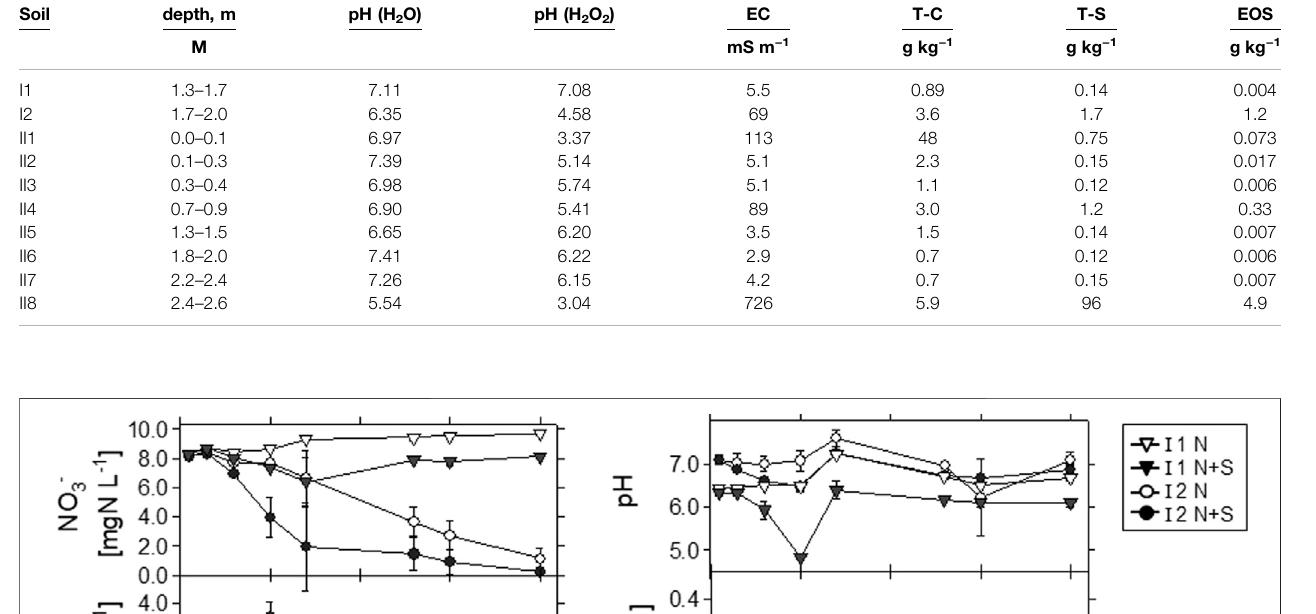
TABLE 1 | Soil chemical properties at streambanks I and II. EC, electric conductivity; T-C, total carbon; T-S, total sulfur; EOS, easily oxidizable sulfur. Soil depth, m